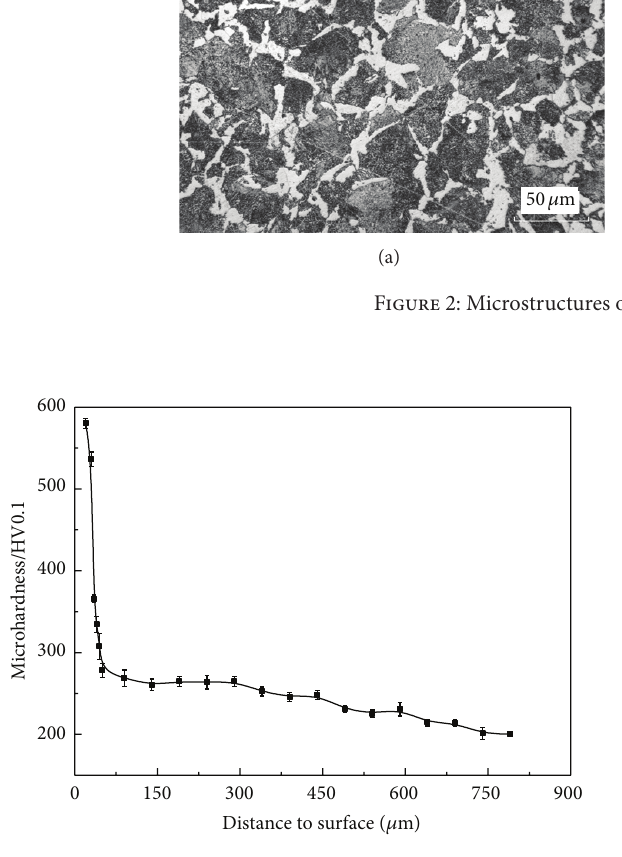
Figure 3: Microhardness profile of the